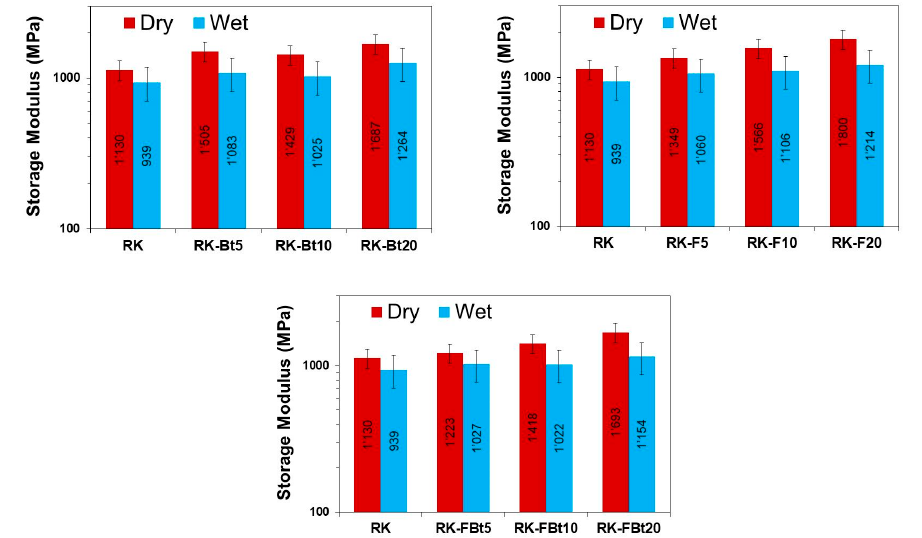
Figure 7. Storage modulus at 37 °C of all samples investigated, in wet and dry conditions.